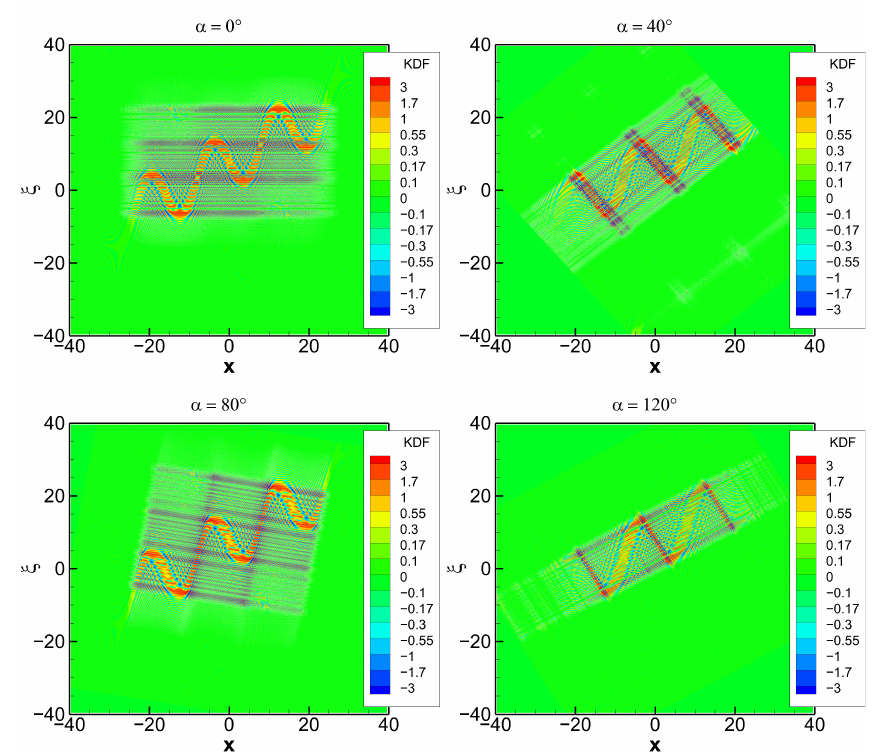
Figure 7. KDF ρ K α of function ˜ ψ α ( y ) interpolated to the unrotated coordinates ( x , ξ ) . The rotation angle α takes the values of 0 ◦ , 40 ◦ , 80 ◦ , and 120 ◦ .